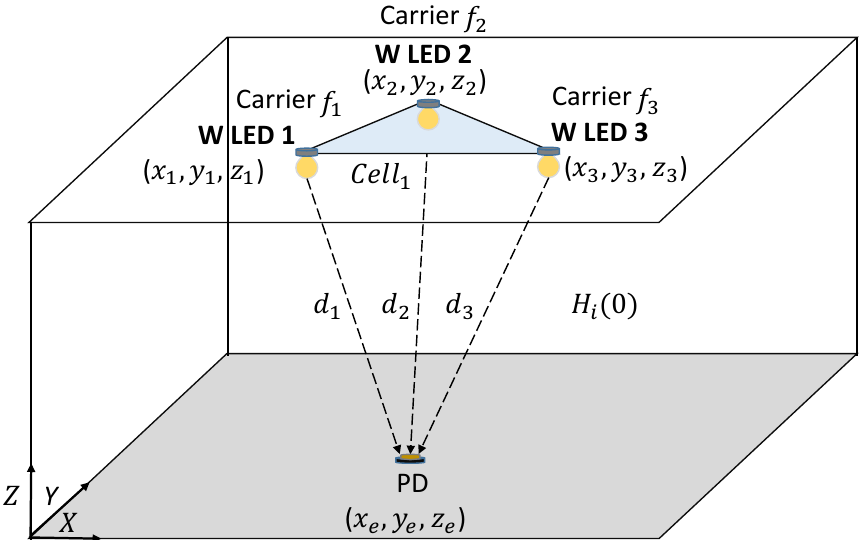
Figure 1. Architecture and geometric model of the VLP for one cell based on three